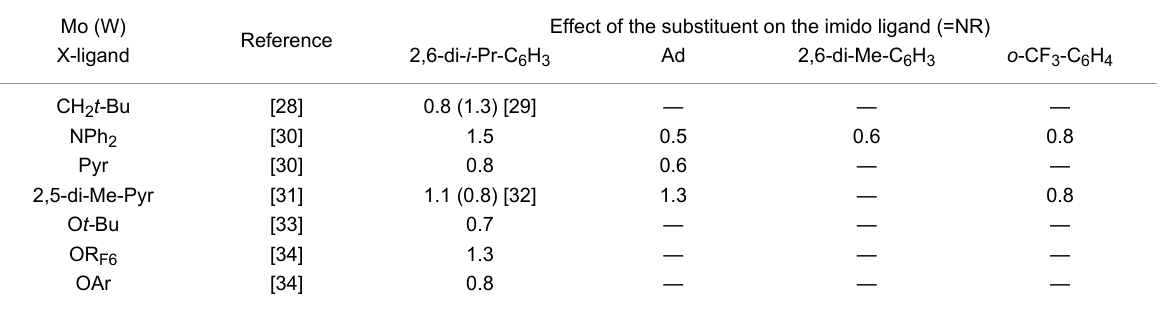
Table 1: Stereoselectivity of well-defined silica supported catalysts of general formula [( ≡ SiO)(X)M(=CHR’)(=NR)] with M = Mo or W: ( E / Z )-ratio at low conversions in propene metathesis. Mo (W)